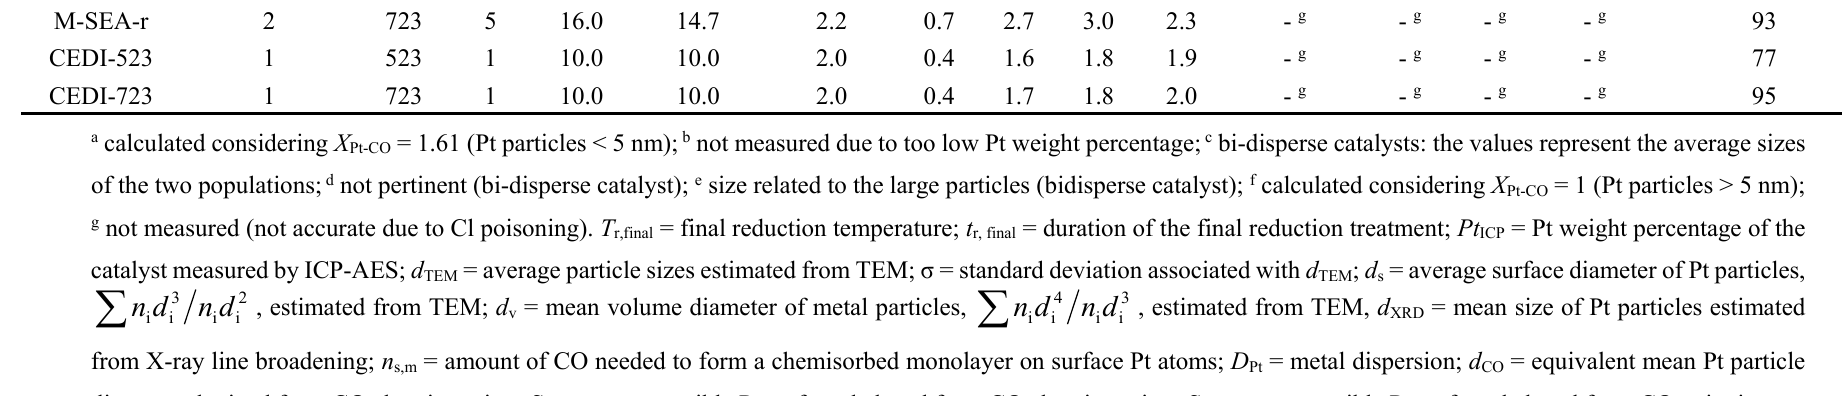
Table 1. Catalyst characterization results. WI, wet impregnation; WI-R, WI-reduction; SEA, strong electrostatic adsorption; M-SEA, multiple SEA; CEDI, charge-enhanced dry impregnation; -r, reused. Catalyst cycles